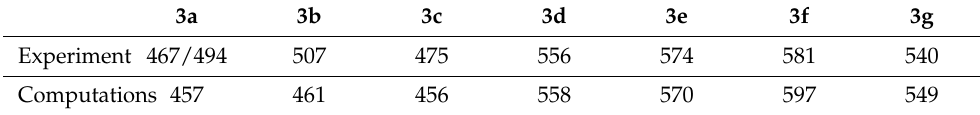
Table 2. The experimental and calculated longest wavelength in the UV/Vis spectra of 3a – 3g . 3a 3b 3c 3d 3e 3f 3g Experiment 467/494 507 475 556 574 581 540 Computations